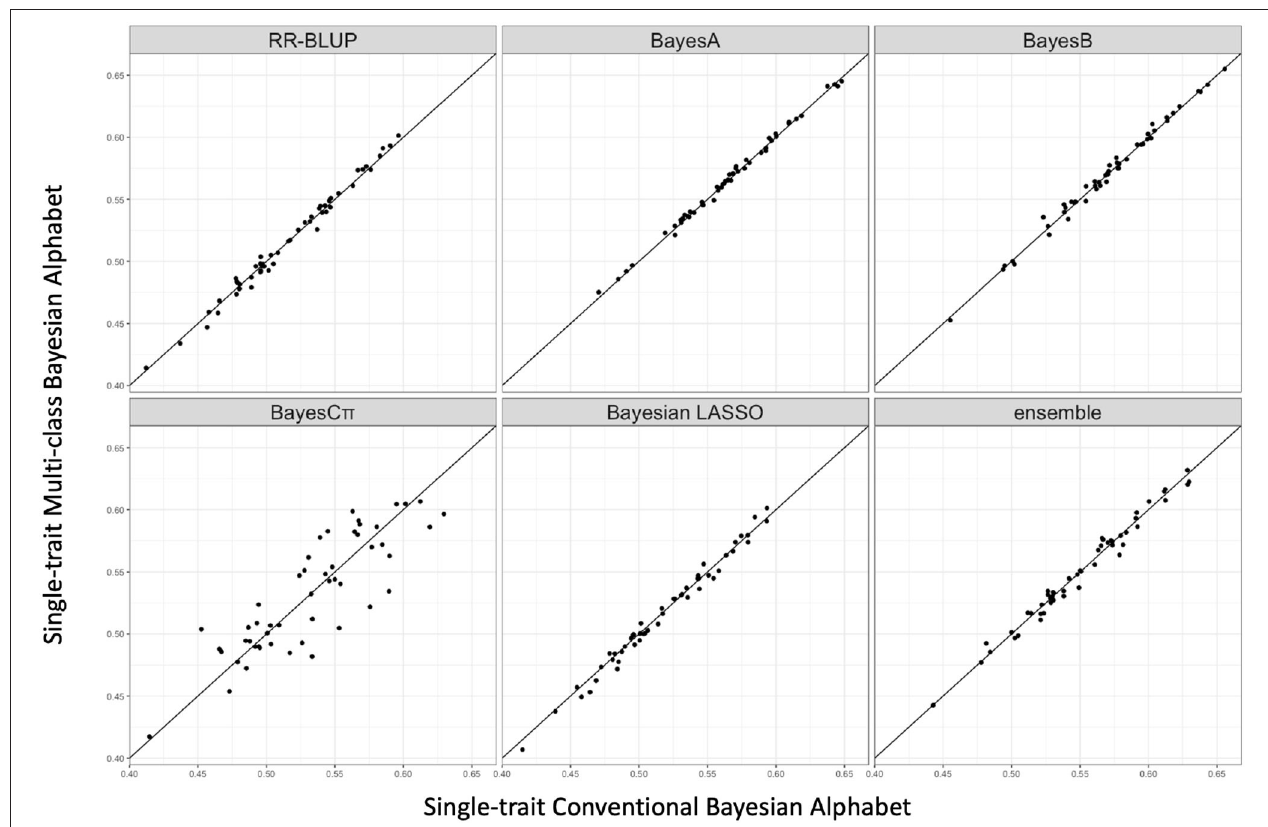
FIGURE 3 | The pairwise prediction accuracy comparisons between conventional Bayesian method and multi-class Bayesian Alphabet using genome annotation classes for the trait 13-week tenth rib backfat (mm) from pig real data. The x-axis represents the genomic prediction accuracy obtained from conventional Bayesian method; the y-axis represents the genomic prediction accuracy obtained from multi-class Bayesian Alphabet method; the diagonal line is used for reference such that a dot above the line represents a validation with higher accuracy for multi-class Bayesian Alphabet. No significant differences were found ( p < 0.1).